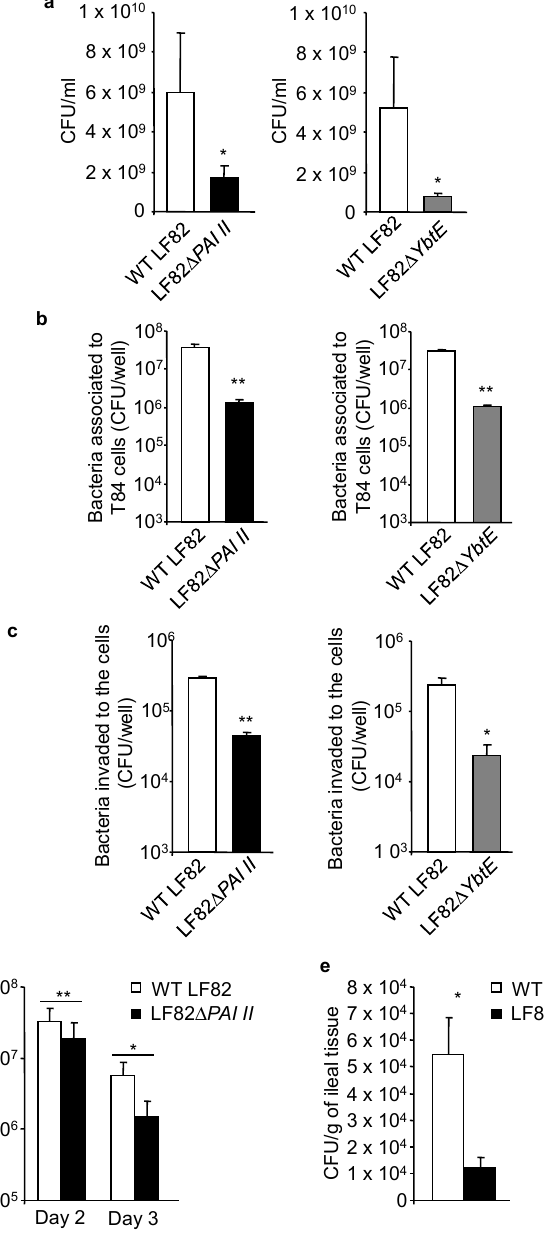
Figure 2. Loss of yersiniabactin affects AIEC LF82 growth in competition experiments. ( a ) The same amount (100 colony-forming units (CFU)) of LF82 ∆ PAI II or LF82 ∆ YbtE mutant was incubated with wild-type (WT) LF82 in 10 mL of LB medium. After one night, bacterial number was counted using LB agar plates. Data are means ± SEM of four replicates and are representatives of three independent experiments. * p < 0.05; by Mann–Whitney test. ( b , c ) T84 cells were infected with a combination of the same amounts of wild-type LF82 and LF82 Δ PAI II or LF82 Δ YbtE (10 wild-type LF82 and 10 mutant bacteria per cell). ( b ) After 3 h of infection, the cells were washed, and the number of bacteria associated with the cells was determined. Data are means ± SEM of six replicates and are representatives of two independent experiments. ** p ≤ 0.01 by Mann–Whitney test. ( c ) After 3 h of infection, the cells were washed and incubated with gentamicin for 1 h, and the number of bacteria that invaded to the cells was determined. Data are means ± SEM of six replicates and are representatives of two independent experiments. * p < 0.05, ** p ≤ 0.01 by Mann–Whitney test. ( d , e ) CEABAC10 mice were orally infected with the same number (10 9 CFU) of LF82 Δ PAI II and wild-type LF82. Quantification of wild-type LF82 and LF82 Δ PAI II numbers in the feces collected at days 2 and 3 post-infection ( d ) or associated with the ileal mucosa determined on the day of sacrifice ( e ) (day 3 post-infection). Data are means ± SEM of N = 9 mice/group. * p < 0.05, ** p ≤ 0.01 by Wilcoxon test.